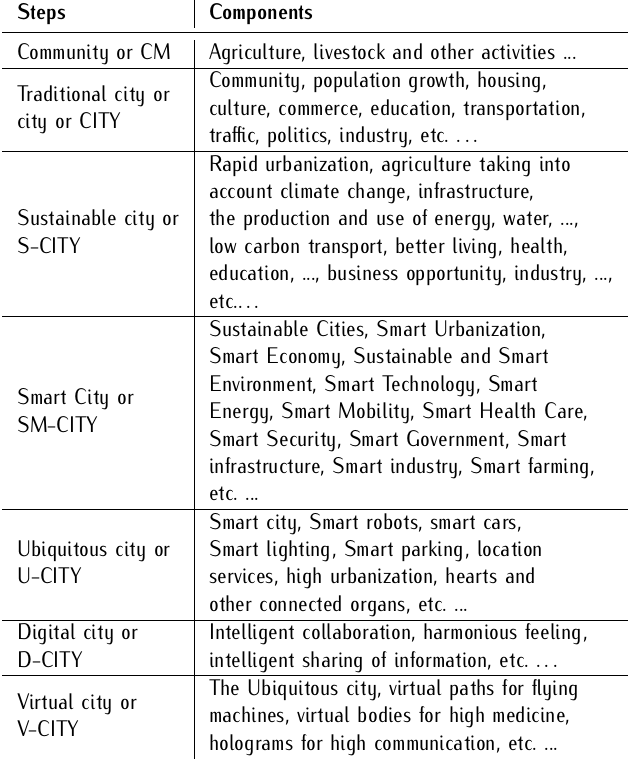
Table 1. Summary of the components of the different steps of the ideological model